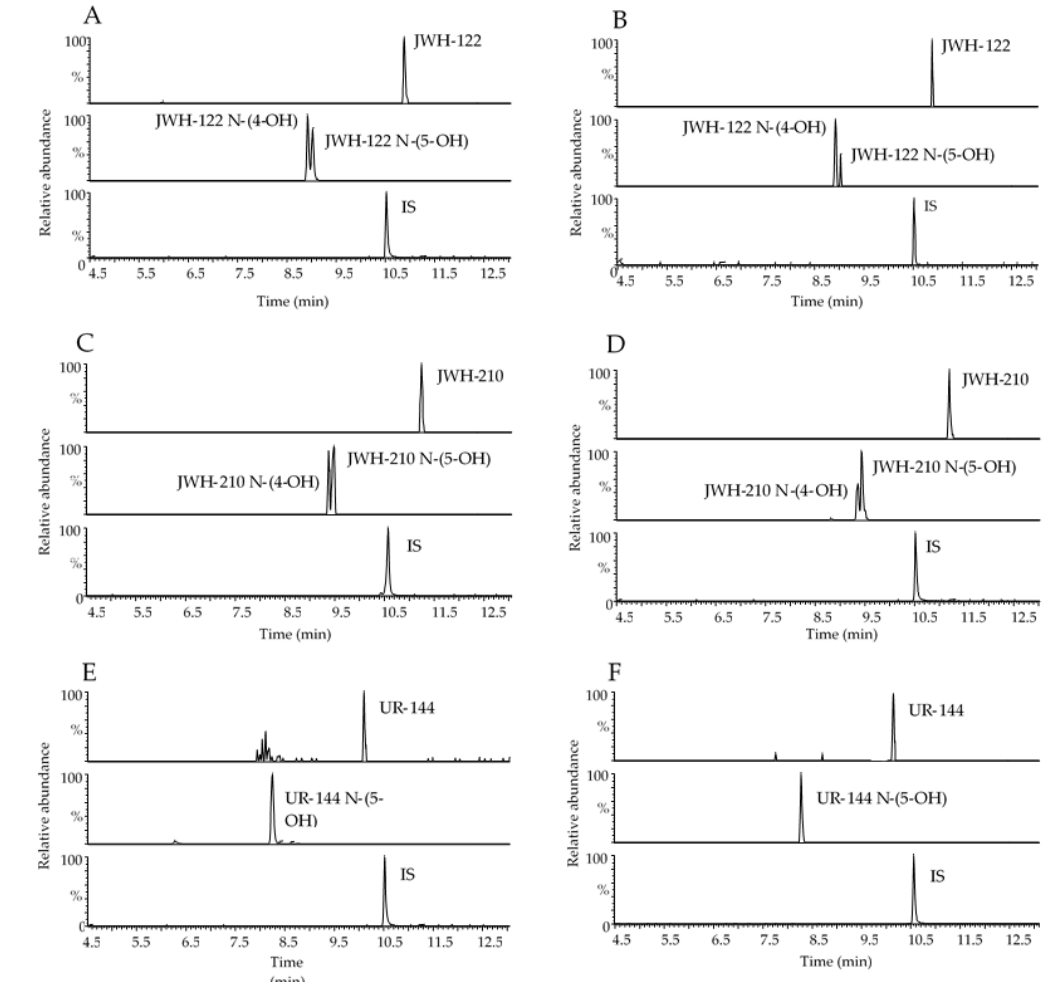
Figure 2. Representative range-mass UHPLC-HRMS chromatograms of 400 µL OF extract spiked with 0.5 ng/mL JWH-122, JWH-122 N-(4-OH) and JWH-122 N-(5-OH) ( A ), 0.5 ng/mL JWH-210, JWH-210 N-(4-OH) and JWH-210 N-(5-OH) ( C ), 0.5 ng/mL UR-144 and UR-144 N-(5-OH) ( E ); OF samples of consumers containing 3.14 ng/mL JWH-122, 0.29 ng/mL JWH-122 N-(4-OH) and JWH-122 N-(5-OH) in traces under the LOQ ( B ); 7.30 ng/mL JWH-210, 0.29 ng/mL JWH-210 N-(4-OH) and 0.66 ng/mL JWH-210 N-(5-OH) ( D ); 6.81 ng/mL UR-144 ( F ). IS, internal standard .